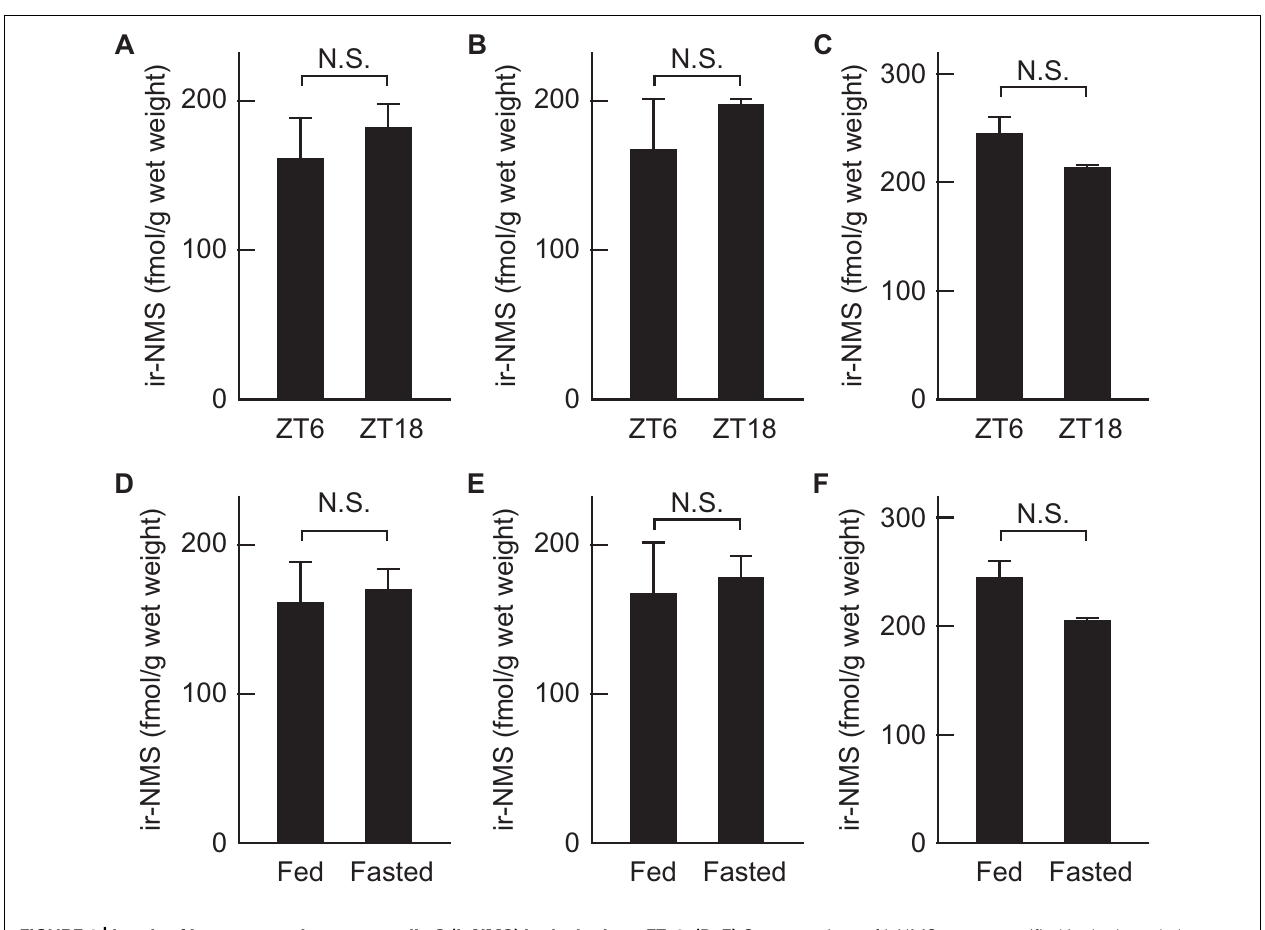
FIGURE 6 | Levels of immunoreactive neuromedin S (ir-NMS) in the brain of rats maintained under light/dark cycling, and of fasted rats. (A–C) Concentrations of ir-NMS were quantified in the hypothalamus (A) , midbrain (B) , and pons–medulla oblongata (C) of rats under the light at ZT6 and dark at